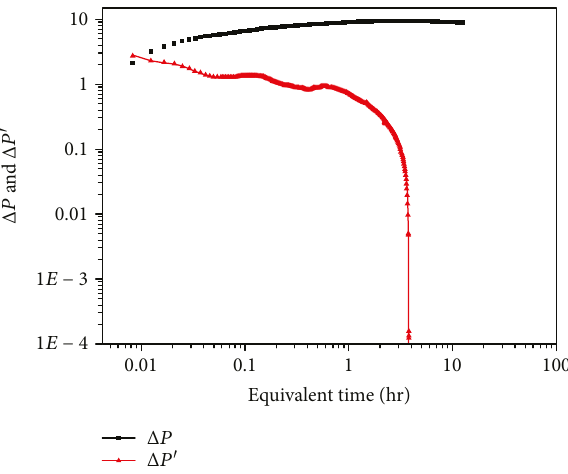
Figure 30: The log-log plot of well B last BU. On this plot, the pressure derivative also decreases quickly at late time.